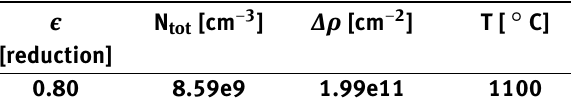
Table 1: Input parameters used in the statistical